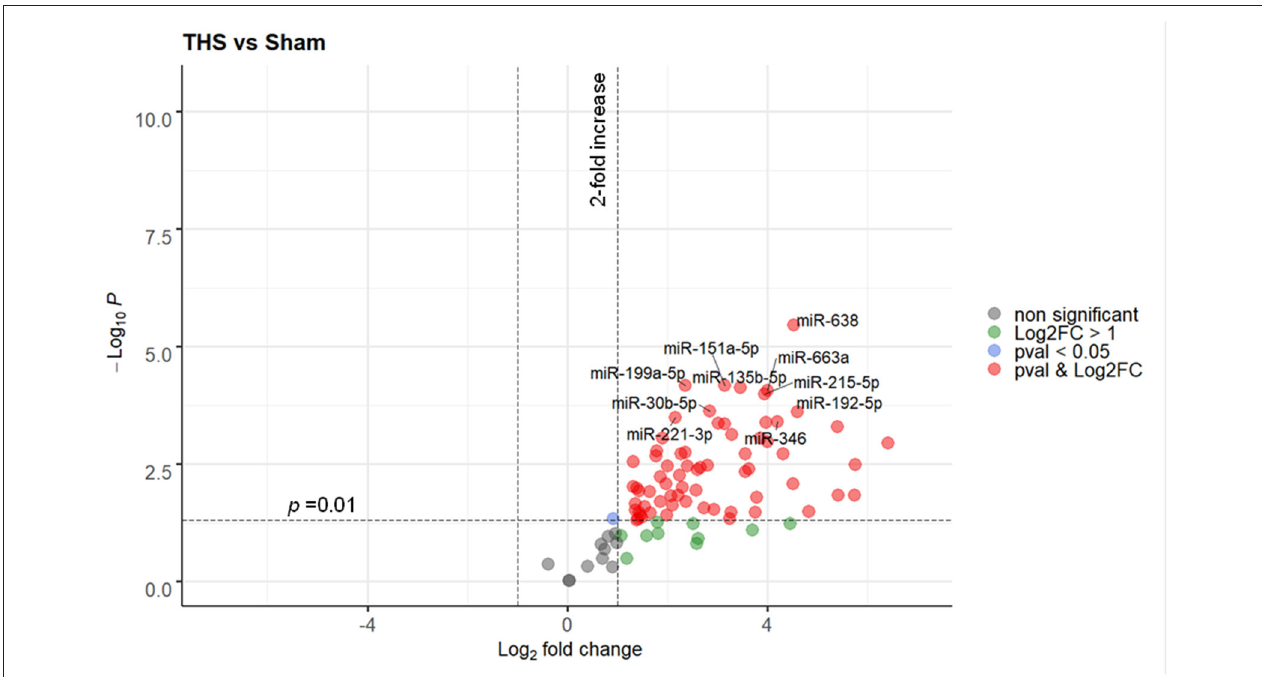
FIGURE 1 | Volcano plot depicting the Log 2 -transformed fold change (LogFC, x-axis) of circulating miRNAs in THS compared to controls (sham) in relation to their p value ( − Log10 (pval), y-axis). In total 90 miRNAs were included in the analysis. The 10 most significantly regulated miRNAs (lowest pval) by THS are labeled. Sham group ( n = 4 animals); THS group ( n = 8